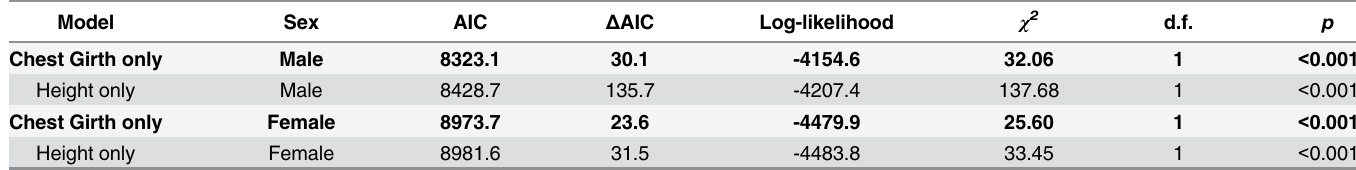
Table 3. Comparison of linear mixed-effects models predicting weight from other measurable body parameters.